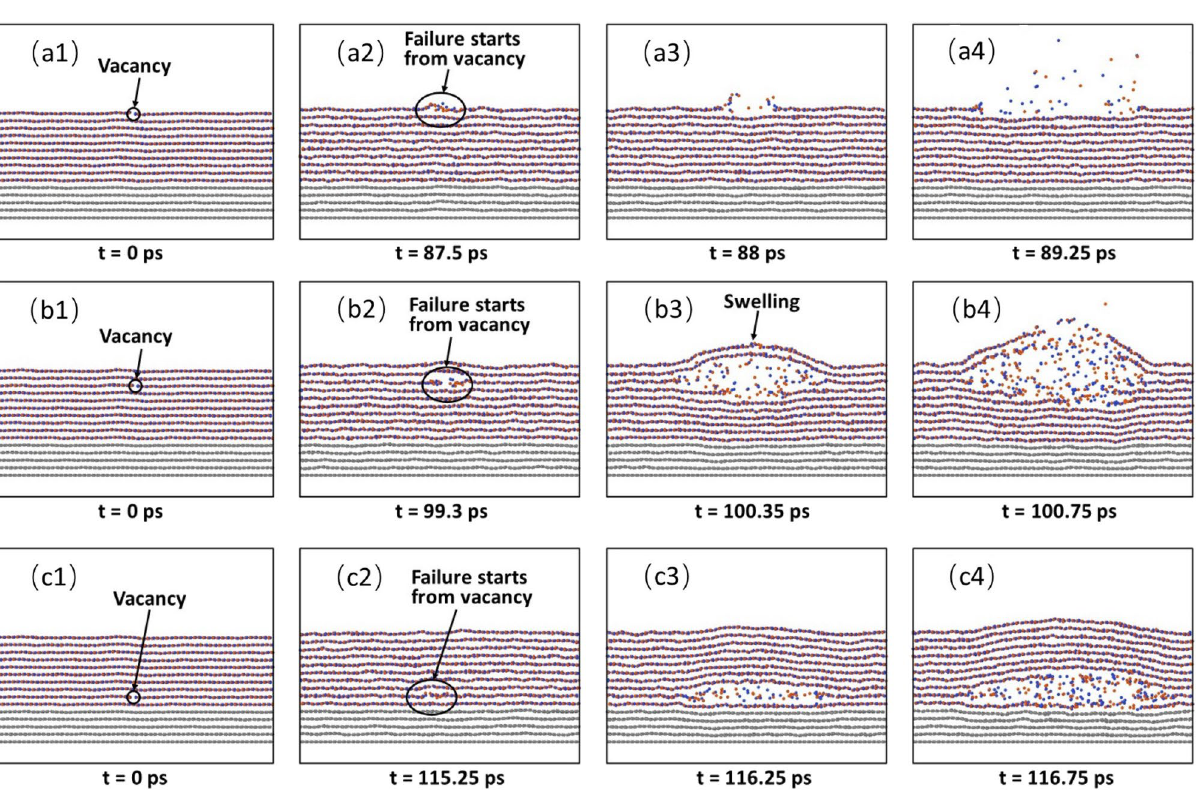
Figure 6. Snapshots of failure processes for a single B vacancy at a different h-BN layer. ( a1 – a4 ) B vacancy at the top layer. ( b1 – b4 ) B vacancy at the 3rd h-BN layer. ( c1 – c4 ) B vacancy at the 9th h-BN